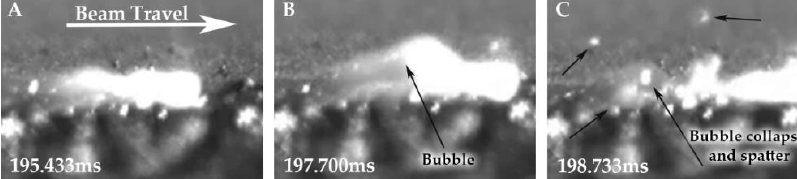
Figure 16. Representative frames of high-speed video footage showing the EB-PBF of a single layer disc on hydrogen-treated HO-Cu powder at timestamps 195.433 ms ( A ), 197.700 ms ( B ), 198.733 ms ( C ).